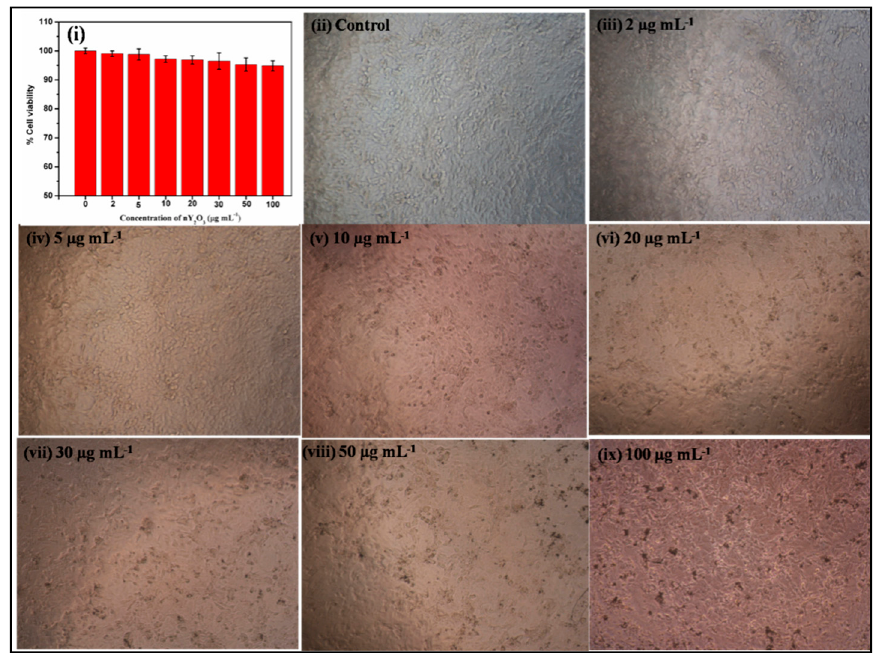
Figure 4. ( i ) Percentage of cell viability and ( ii – ix ) morphological view of HEK 293 cell line with various concentrations of nY 2 O 3 .